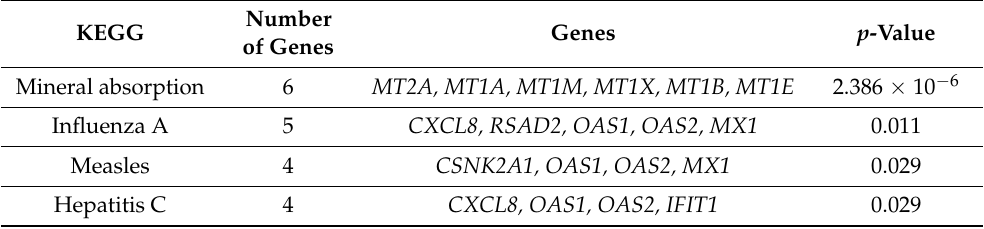
Table 3. Cells exposed to the rough surfaces (Ra = 1 µ m) of Y-TZP discs for 96 h ( p -value < 0.05). Number Genes p KEGG of Genes